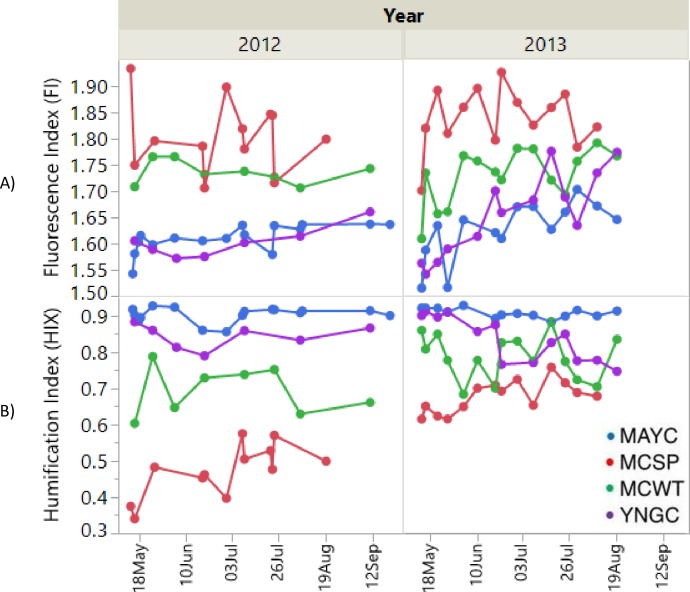
Seasonal and interannual fluorescence characteristics by site for 2012 and 2013.(A) Fluorescence index and (B) Humification index.